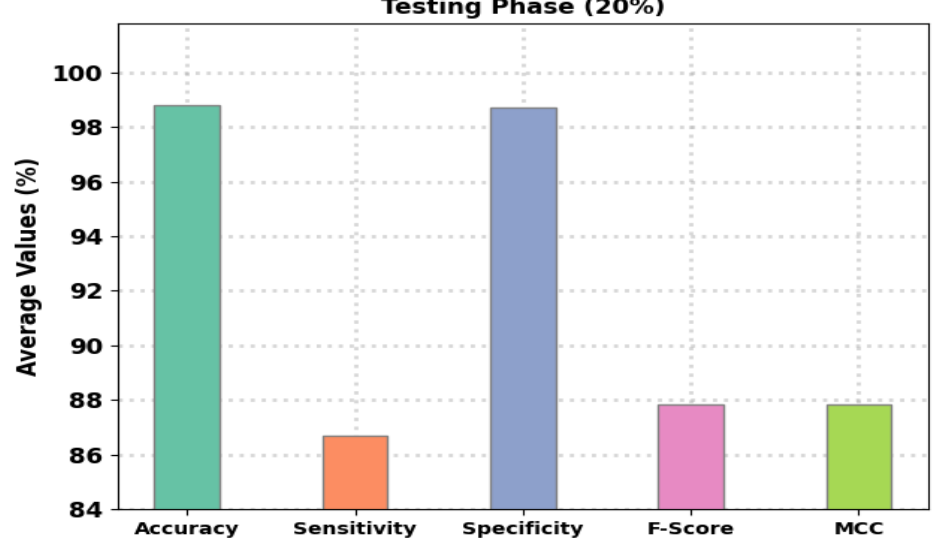
Figure 9. Average analysis of the RFER-EADL algorithm for 20% of the TS dataset.